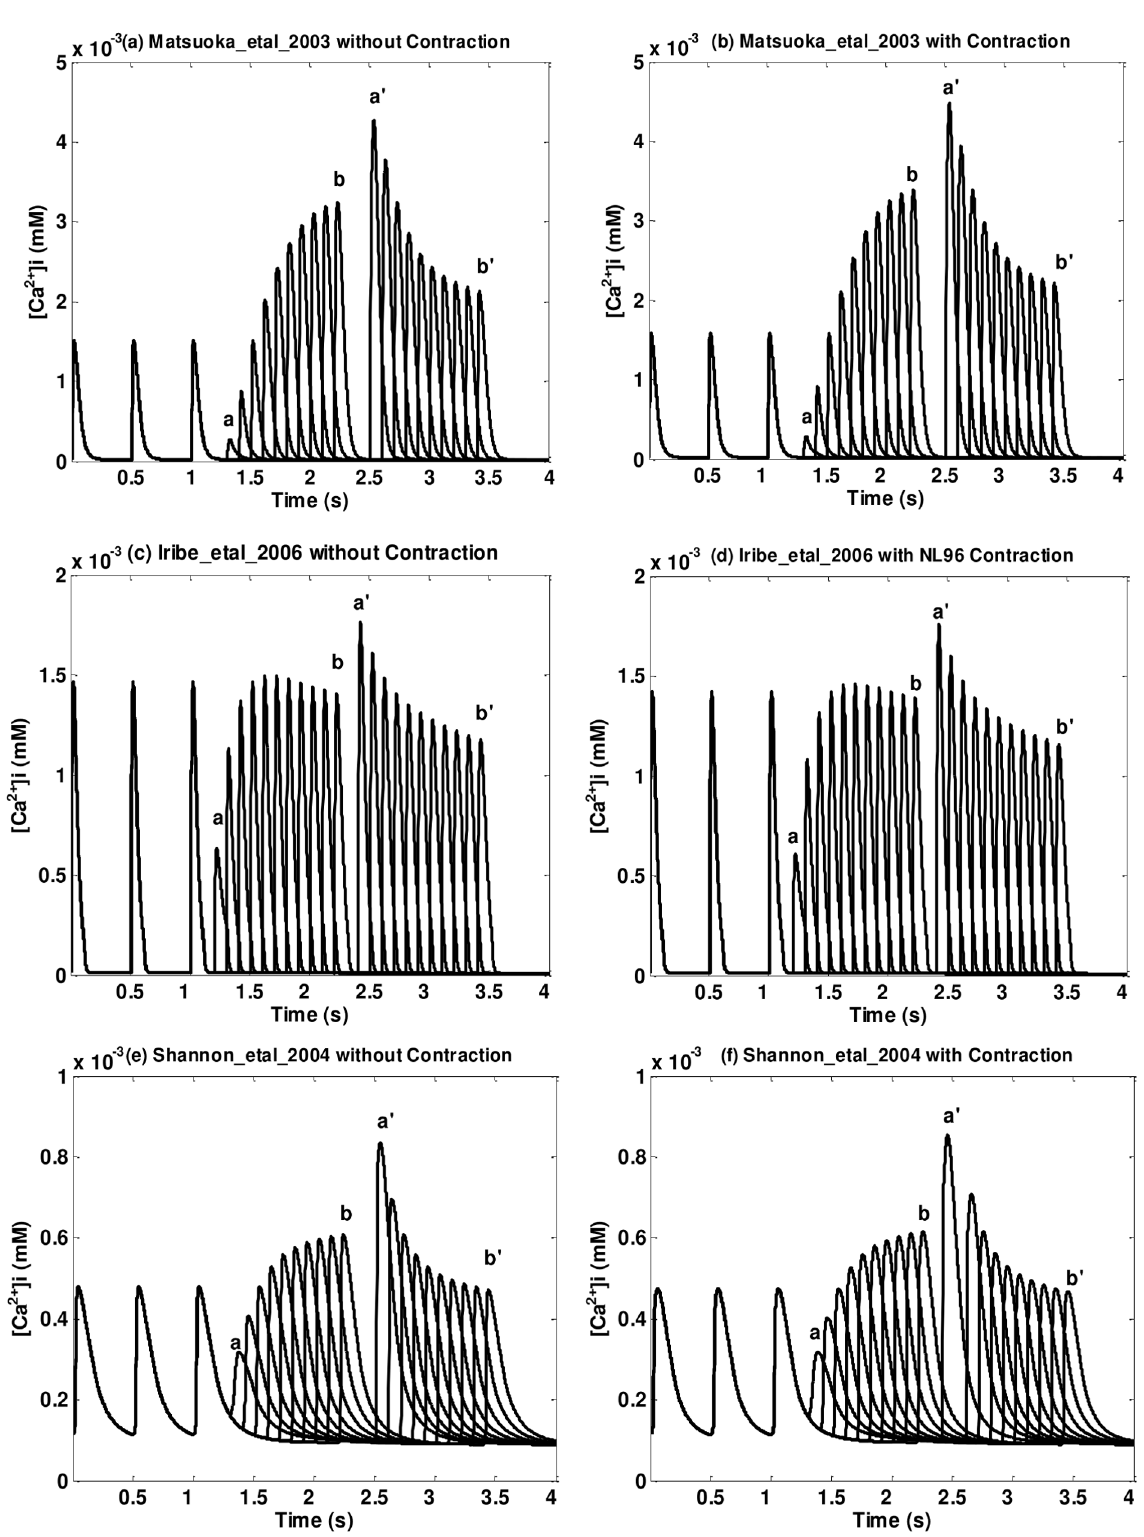
Fig 4. Postextrasystolic potentiation in [ Ca 2+ ] i transient for three models of Type One and Two. (a) (b) Matsuoka_etal_2003 without/with contraction; (c) (d) Iribe_etal_2006 without/with contraction (NL96); (e) (f) Shannon_etal_2004 without/with contraction. The first three beats are priming beats; from beat a to beat b are ES beats with different ESIs; from a ' to b ' are PES beats with a fixed PESI (fully restituted PESI, defined in Step Three in the Pacing Protocol of